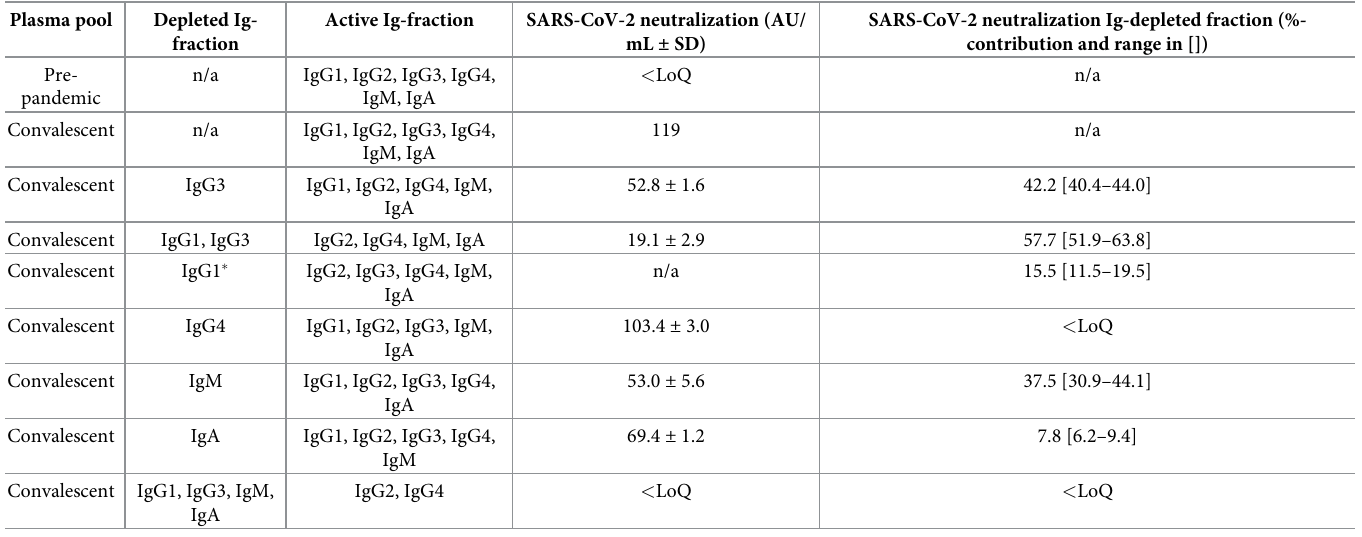
Table 1. Summary of individually depleted plasma pool samples and results of neutralization of